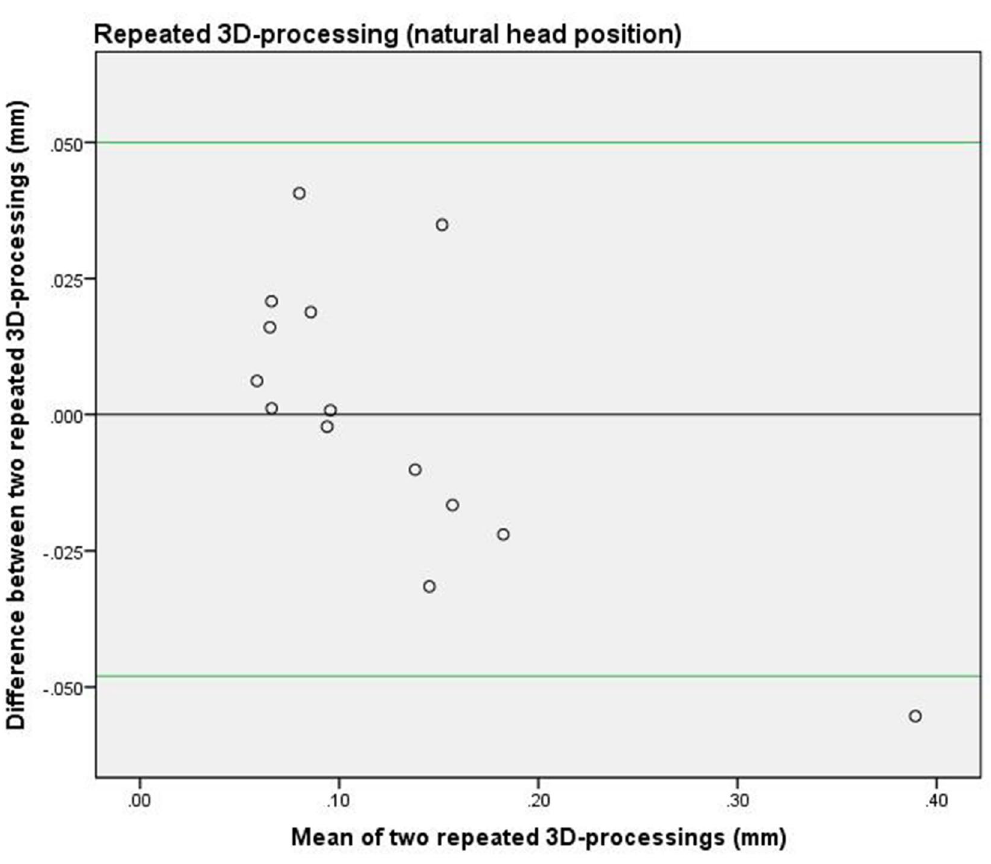
Figure 6. Bland Altman plot of repeated data processing (NHP). The 3D-data processing was repeated for the second minute-interval scans of the natural head position and comprised the cross section of the lateral iris of the left eye. The green lines represent the upper and lower limits of agreement between the two processing